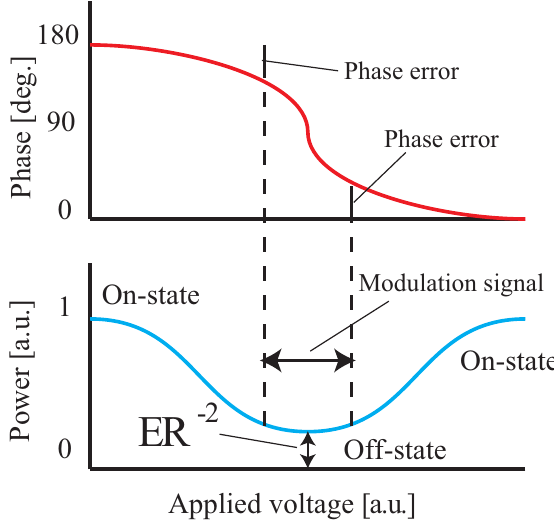
Figure 10. Schematic of optical phase and amplitude response of an MZM with finite ER [12]. As shown in Figure 11, to investigate impact of the phase error due to finite ER, optical fiber transmission using duobinary modulation was demonstrated with varying ER [12].